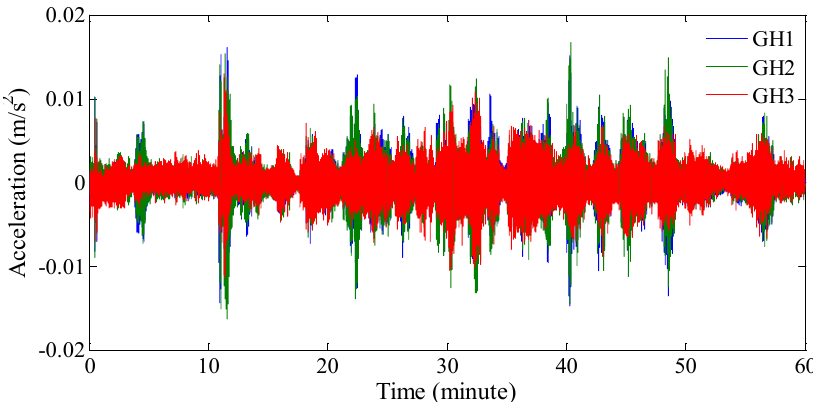
Figure 1. Typical responses recorded by three accelerometers in an arch.